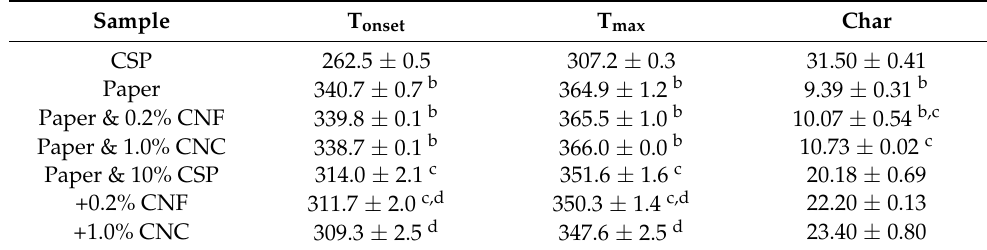
Table 2. Thermal properties of cottonseed protein isolate and paper samples treated with cottonseed protein and nanocellulose formulations.